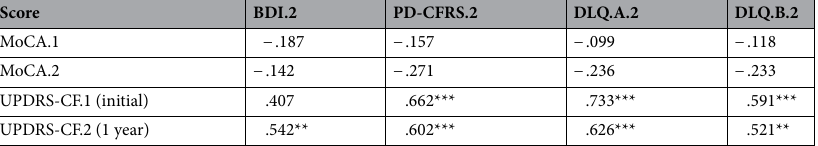
Table 3. Correlations between the first and second MoCA scores, UPDRS-CF features and participants’ second BDI and functional cognitive questionnaires scores at 1-year follow-up. BDI, Beck Depression Inventory 25 ; PD-CFRS, Parkinson’s Disease Cognitive Functional Rating Scale 15 ; DLQ, Daily Living Questionnaire: A, activities and participation, B, cognitive domains 19 . **Correlation is significant at p ≤ .01 level after Bonferroni correction; *** p ≤